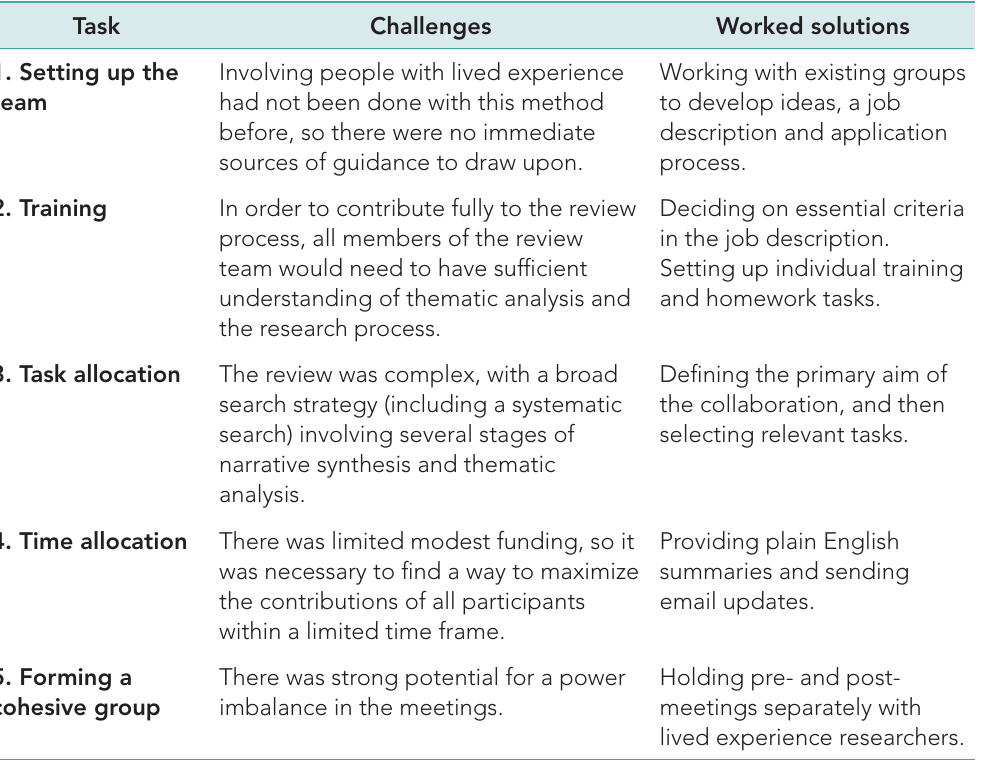
Table 1: Key challenges and worked